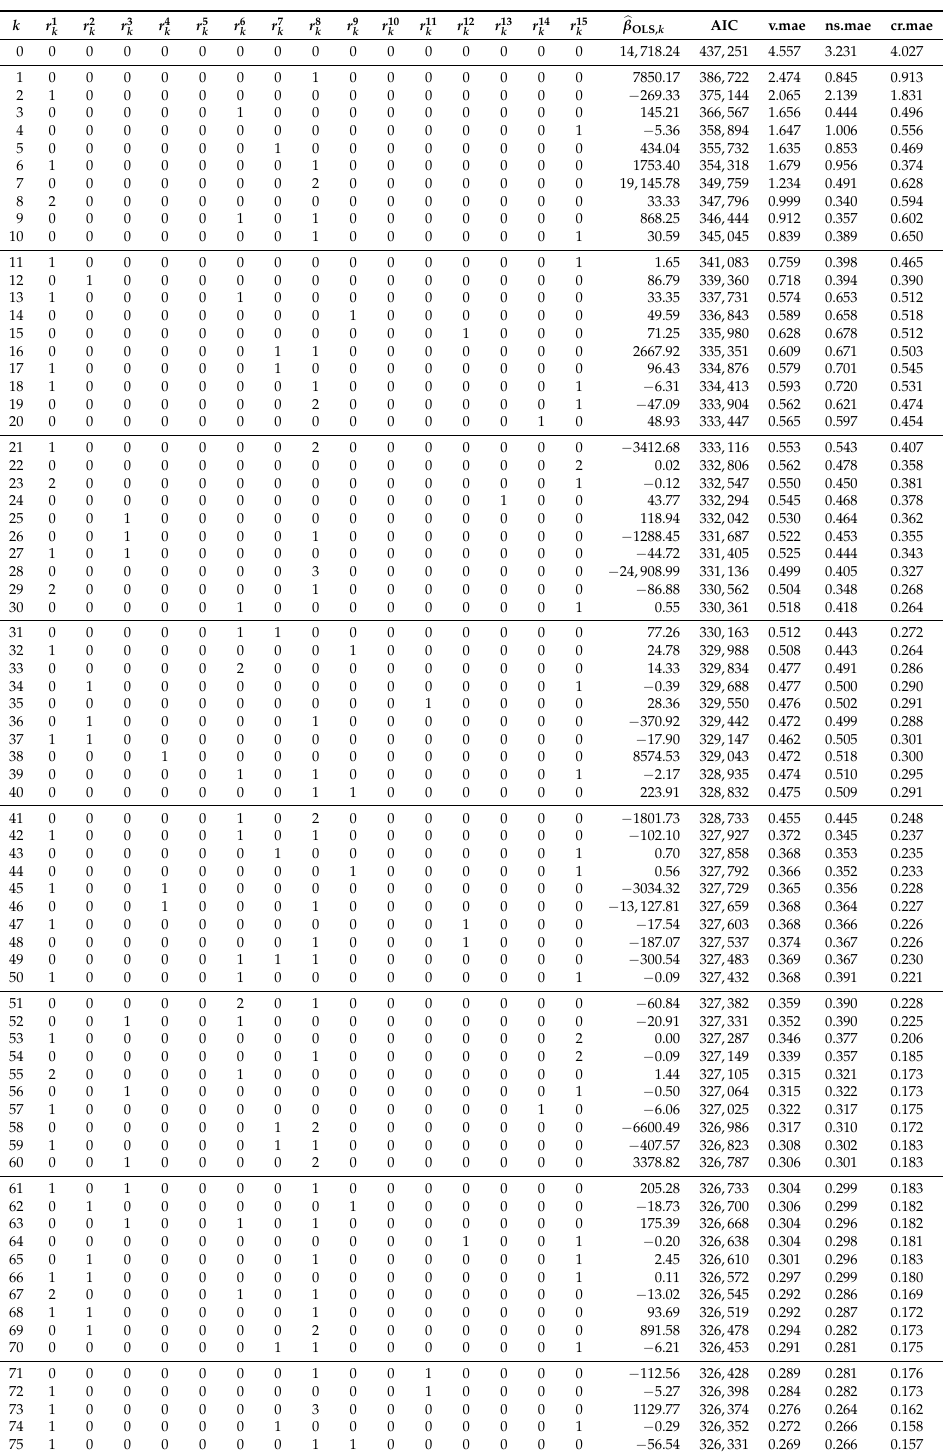
Table A1. Ordinary least squares (OLS) proxy function of BEL derived under 150–443 in the adaptive algorithm with the final coefficients. Furthermore, Akaike information criterion (AIC) scores and out-of-sample mean absolute errors (MAEs) in % after each